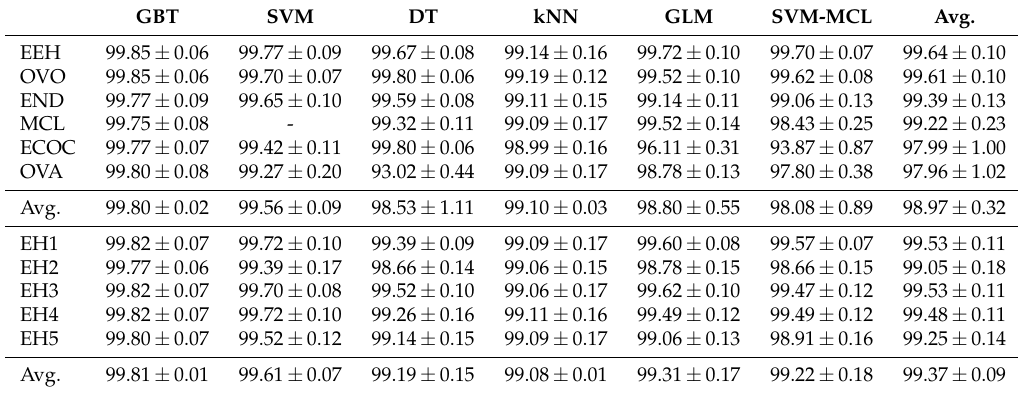
Table 3. Mean κ % (± SE) for the topmost dichotomy of expert hierarchy (EH1) (Stationary vs. ˜Mobile). The first six multi-class decomposition methods are given in order of decreasing average score, the expert hierarchies in alphabetical